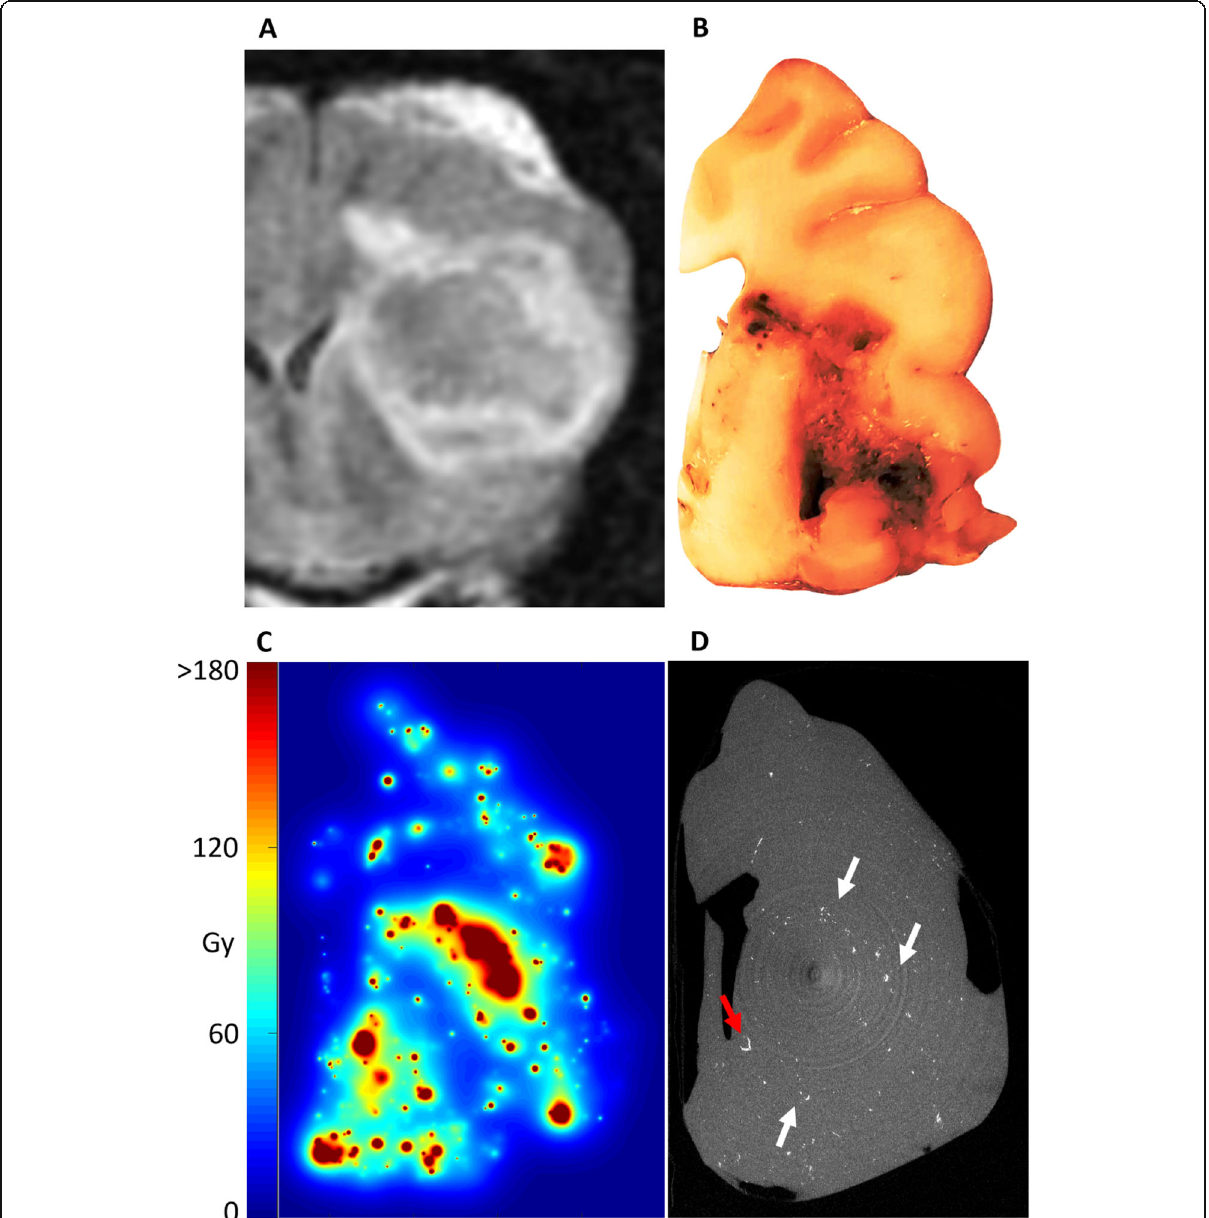
Fig. 7 Gross pathology and microdosimetry for P5. a Pre-treatment T2 FLAIR 1 month prior to therapy. b Formalin-fixed gross pathologic example of involved hemisphere with significant central tumor necrosis. c Microdosimetry showing the absorbed-dose distribution in dog P5 if the dog had survived. At the time of death, only 15% of the absorbed-doses shown had been delivered based on the half-life of 90 Y. d Post-explant microCT showing gross distribution of glass microspheres. Image is a maximum intensity projection of 100 microCT slices with a combined thickness of 900 um. A preference for deposition in the peri-necrotic region of tumor can be seen (white arrows). Occasional filling of end- arterioles/capillaries with microspheres can be visualized (red